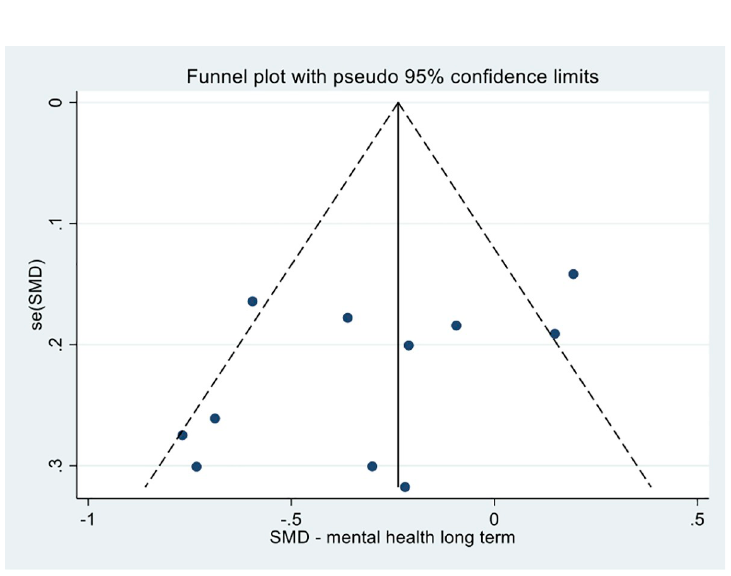
Fig 9. Funnel plot of studies including mental health as a long-term outcome.